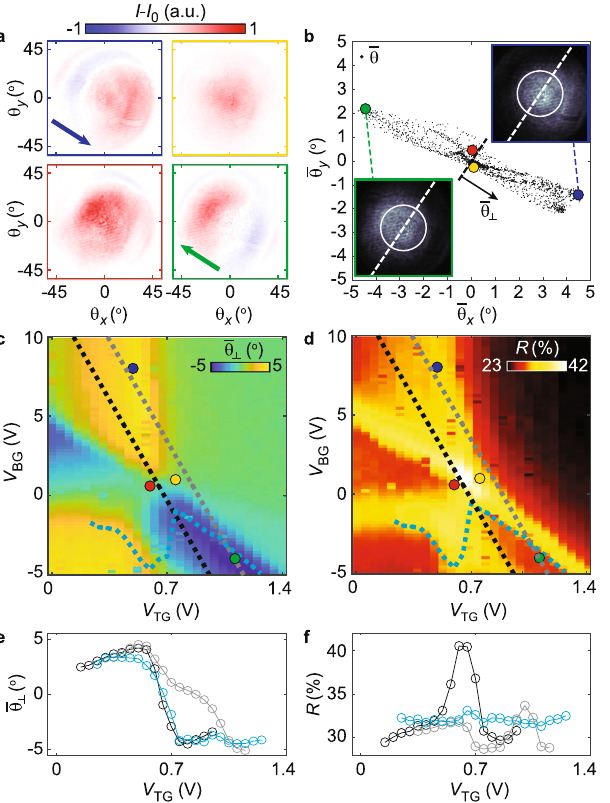
Fig. 2 Continuously tunable beam steering. a Fourier images of re fl ected beam ( λ 0 = 755.6 nm) in the four regimes after subtracting the re fl ection in the highly doped regime ( V BG = 10 V and V TG = 1.4 V). When the exciton resonance is blue-shifted past λ 0 in only one side of the device (blue, green), the beam is de fl ected away from that side. If neither or both are blue-shifted past λ 0 , the phase difference is small and little de fl ection is observed (red, yellow). b Scatter plot of the beam de fl ection ( (cid:1) θ x ; (cid:1) θ y ) for the full range of gate voltages, showing that the de fl ection is perpendicular to the gate edge (dashed line) and continuously tunable. Inset: Fourier images without background subtraction. c The gate dependence of the de fl ection perpendicular to the gate edge ( (cid:1) θ ? ) is in very good agreement with that of the phase difference shown in Fig. 1g. d Gate dependence of re fl ection amplitude. Regions with high re fl ection indicate that one of the resonances crosses through λ 0 . e , f Linecuts indicated by dashed black, teal, and gray lines in ( c ) and ( d ), respectively, highlighting the continuous steering capability and that the re fl ection can be kept relatively constant while de fl ecting the beam. Connecting lines in e and f are guides to the eye. Figure 2d shows the gate dependence of the integrated re fl ection. The different regimes are separated by regions of strong re fl ection, since these indicate that one of the resonances crosses through λ 0 . While the four different regimes are easily identi fi ed, we emphasize that the phase difference, and thus the beam de fl ection, is tuned continuously, as shown in Fig. 2b. The continuous tunability is highlighted in Fig. 2e, showing linecuts from Fig. 2c. Although the re fl ection amplitude is gate dependent (Fig. 2d, f), the re fl ection variations can be reduced substantially while still keeping a similar de fl ection range by avoiding the combined resonance (gray linecut), or even designing a near-iso-re fl ection path in voltage space (teal). advanced control of the wavefront pro fi le, we utilize the device